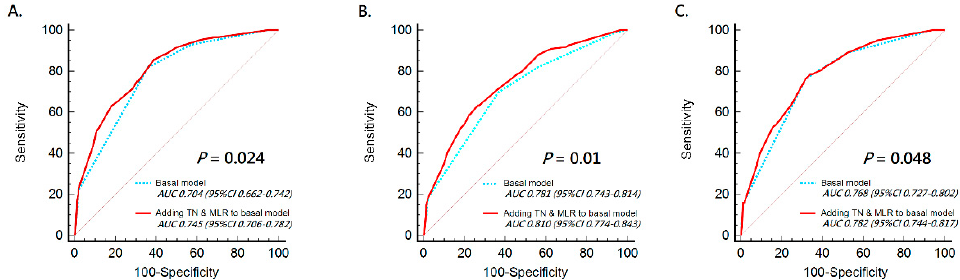
Figure 3. ROC analysis for predictive accuracy of overall survival ( A ), cancer-specific survival ( B ), and recurrence-free survival ( C ) in UTUC patients according to a comparison between the basal model and the basal model combined with tumor necrosis and preoperative MLR. UTUC: upper tract urothelial carcinoma; TN: tumor necrosis; MLR: monocyte-to-lymphocyte ratio.